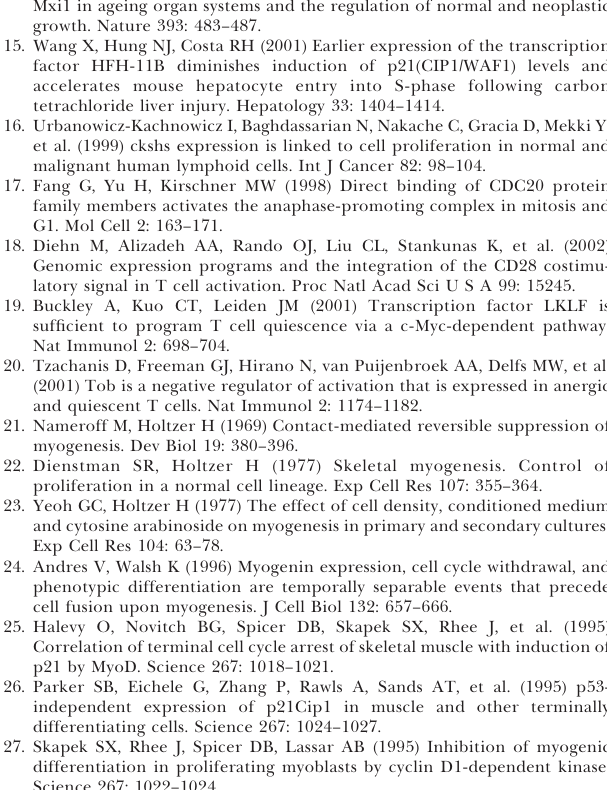
Figure S2. Genes Regulated in Opposite Directions by Mitogen Withdrawal and Loss of Adhesion Genes upregulated by mitogen withdrawal and downregulated by loss of adhesion, and vice versa, were identified by template-matching using a threshold of two genes by chance. The signatures at quiescence initiation and quiescence maintenance are shown as heat maps. Found at DOI: 10.1371/journal.pbio.0040083.sg002 (2.6 MB TIF). Table S1. Quiescence Genes Involved in Intercellular Communication Genes regulated by one, two, or three signals at 14 h, 4 d, or 20 d that are involved in intercellular communication are listed, along with their classification by functional